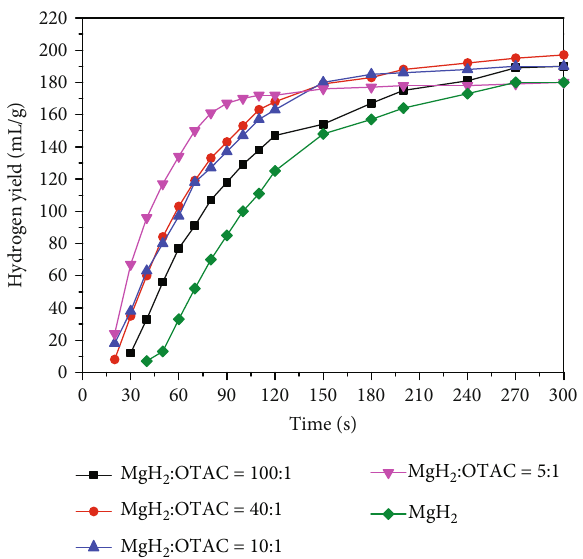
Figure 5: The e ff ect of di ff erent TPABr dosages on hydrogen generation. Table 4: Surface tension values of aqueous solutions with di ff erent TPABr dosages.